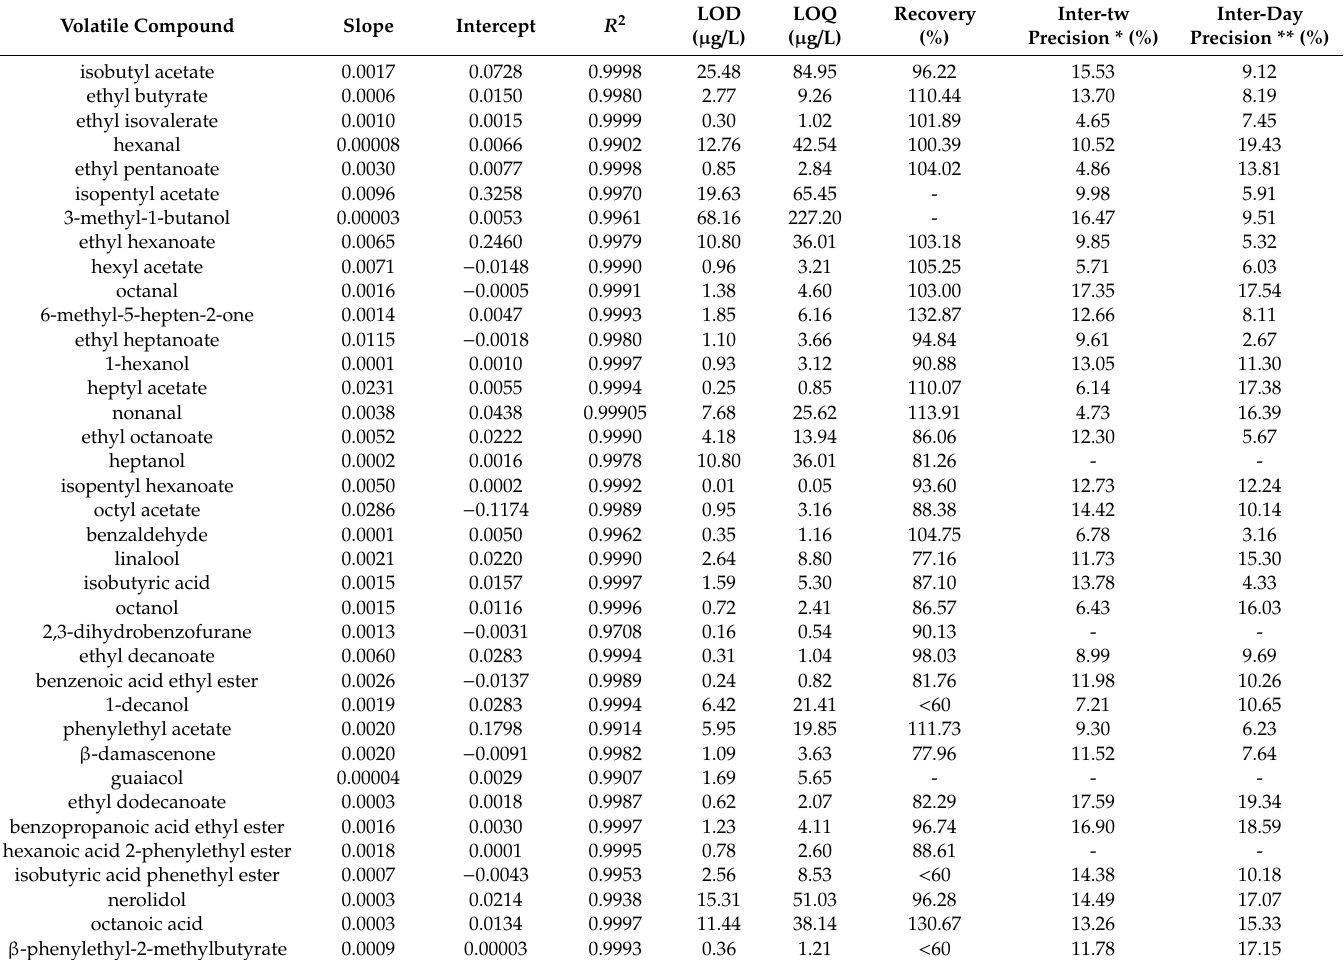
Table 2. Analytical features of the headspace sorptive extraction (HSSE) method for the studied